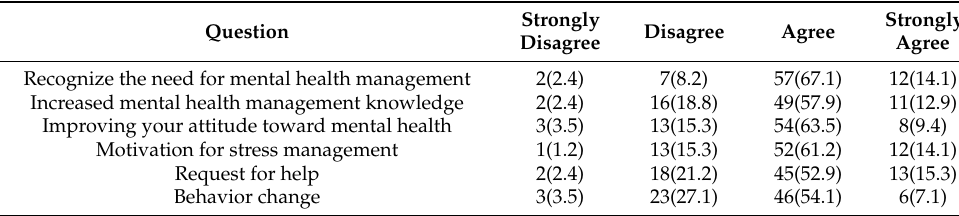
Table 3. Changes in mental health management after using the mental health mobile app ( N = 78).